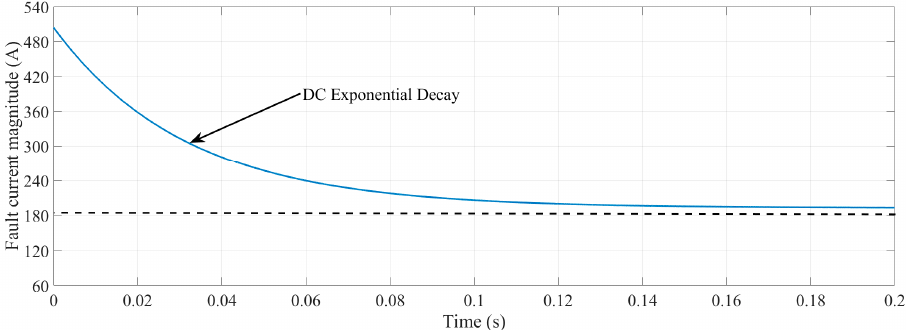
Figure 3. DC decay feature of AC fault currents.